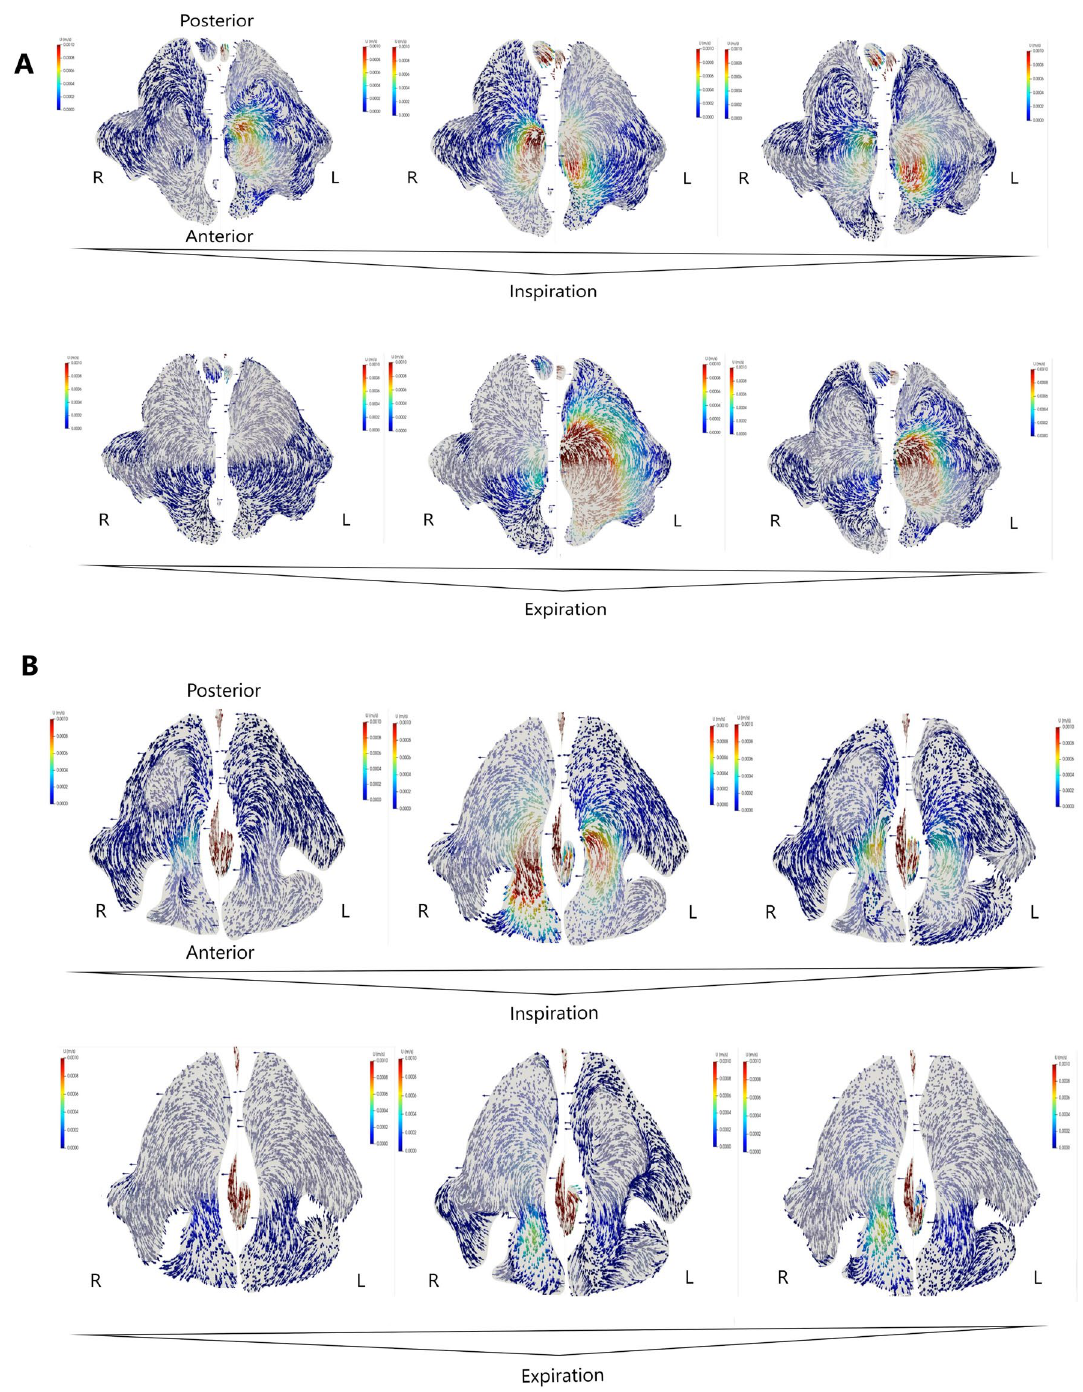
Figure 4. ( A ) Airflow in the maxillary sinus of Patient 3 (axial projection, middle part of maxillary sinus). Bilateral visualization of the maxillary sinus lumen, the nasal cavity excised in the middle of its height. Inspiration and expiration lasted 2 s each. Measurements were obtained at the start of each phase (first 0.2– 0.3 s), half-point (0.9–1.0 s), end (1.8–2.0 s); ( B ) Airflow in the maxillary sinus of Patient 4 (axial projection, middle part of maxillary sinus). Bilateral visualization of the maxillary sinus lumen, the nasal cavity excised in the middle of its height. Inspiration and expiration lasted 2 s each. Measurements were obtained at the start of each phase (first 0.2–0.3 s), half-point (0.9–1.0 s), end (1.8–2.0